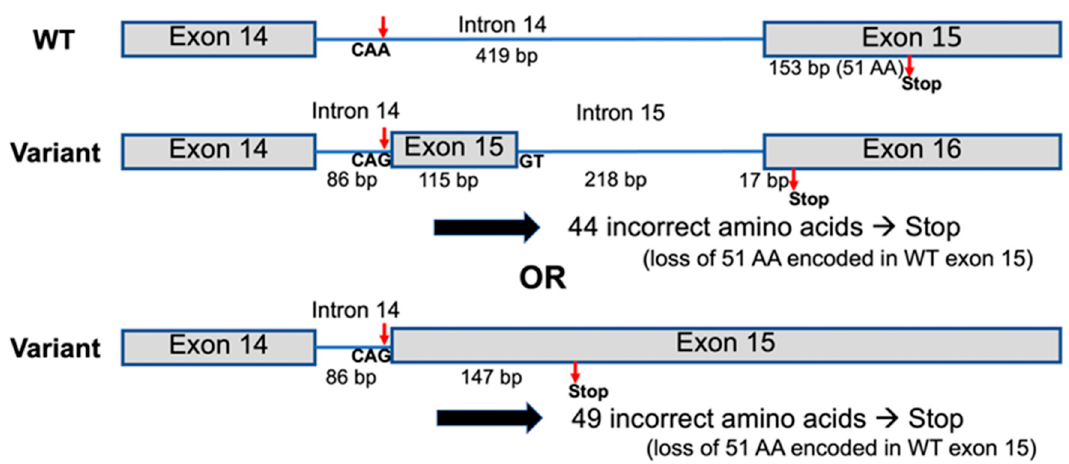
Figure 9. Two possible models for the effect of the P3H1 variant on the splicing of P3H1 isoform a to form new isoforms. The variant CAG sequence is predicted to act as a constitutive splice acceptor site with 89% confidence, compared to an 8.6% chance for the consensus CAA sequence [13]. A GT sequence 116 bp later is predicted to act as a constitutive splice donor with 75% confidence. The use of this splice donor site gives the upper variant model an extra intron and exon and replaces the 51 amino acid residues encoded in exon 15 of isoform a with 44 alternative amino acids, with a frameshift in the final exon leading to an early stop codon. If the splice donor site is not used (lower variant model), intron 14 is reduced to 86 bp, and 49 codons are added from the former intron before a stop codon. In either case, the new C-terminal amino acid sequence is not functional.